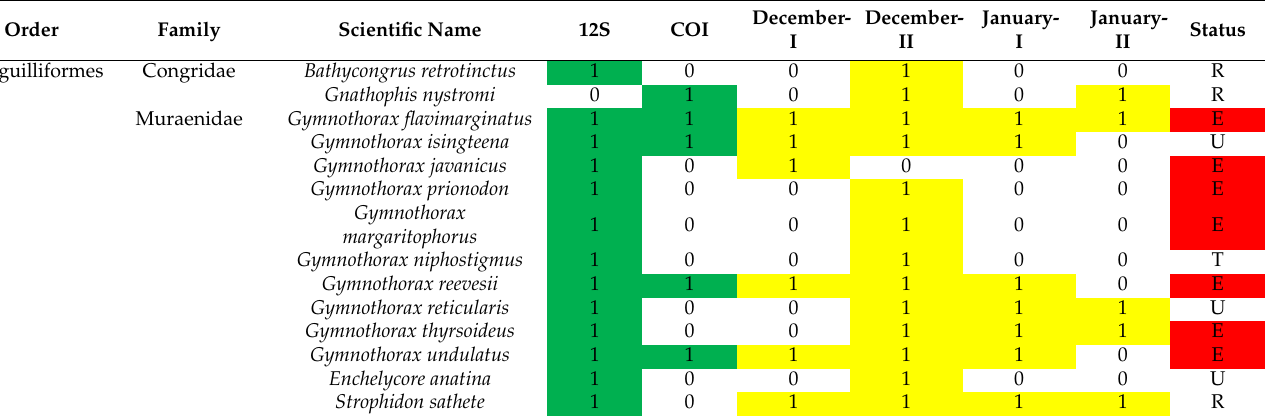
Table 5. List of Anguilliformes detected species in this study.